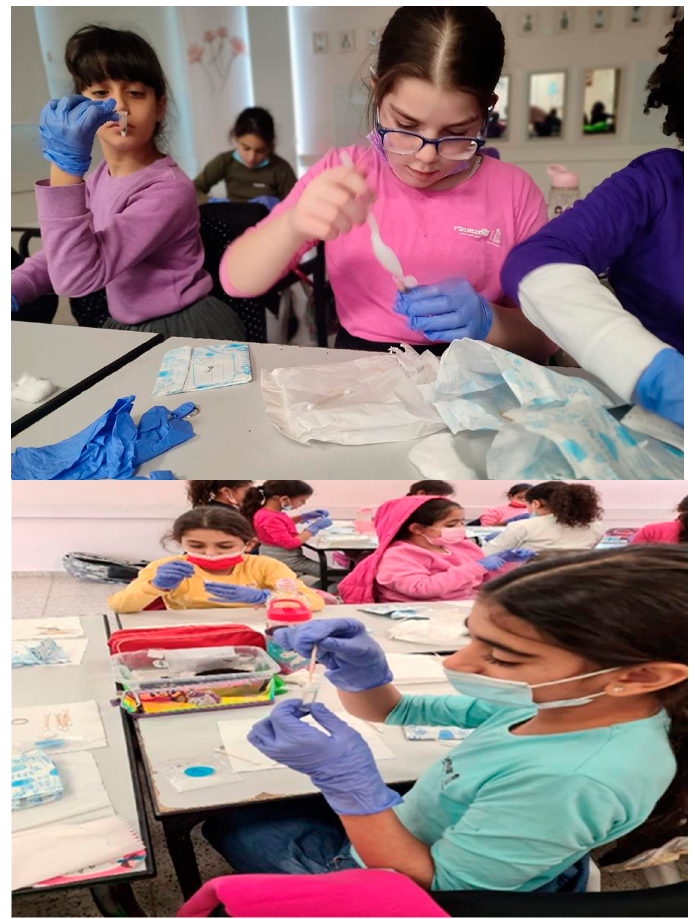
Figure 3. The bean experiment. The left Petri dish contains contaminated soil, and the right Petri dish contains clean soil. Figure 4 shows a pupil filtering water.